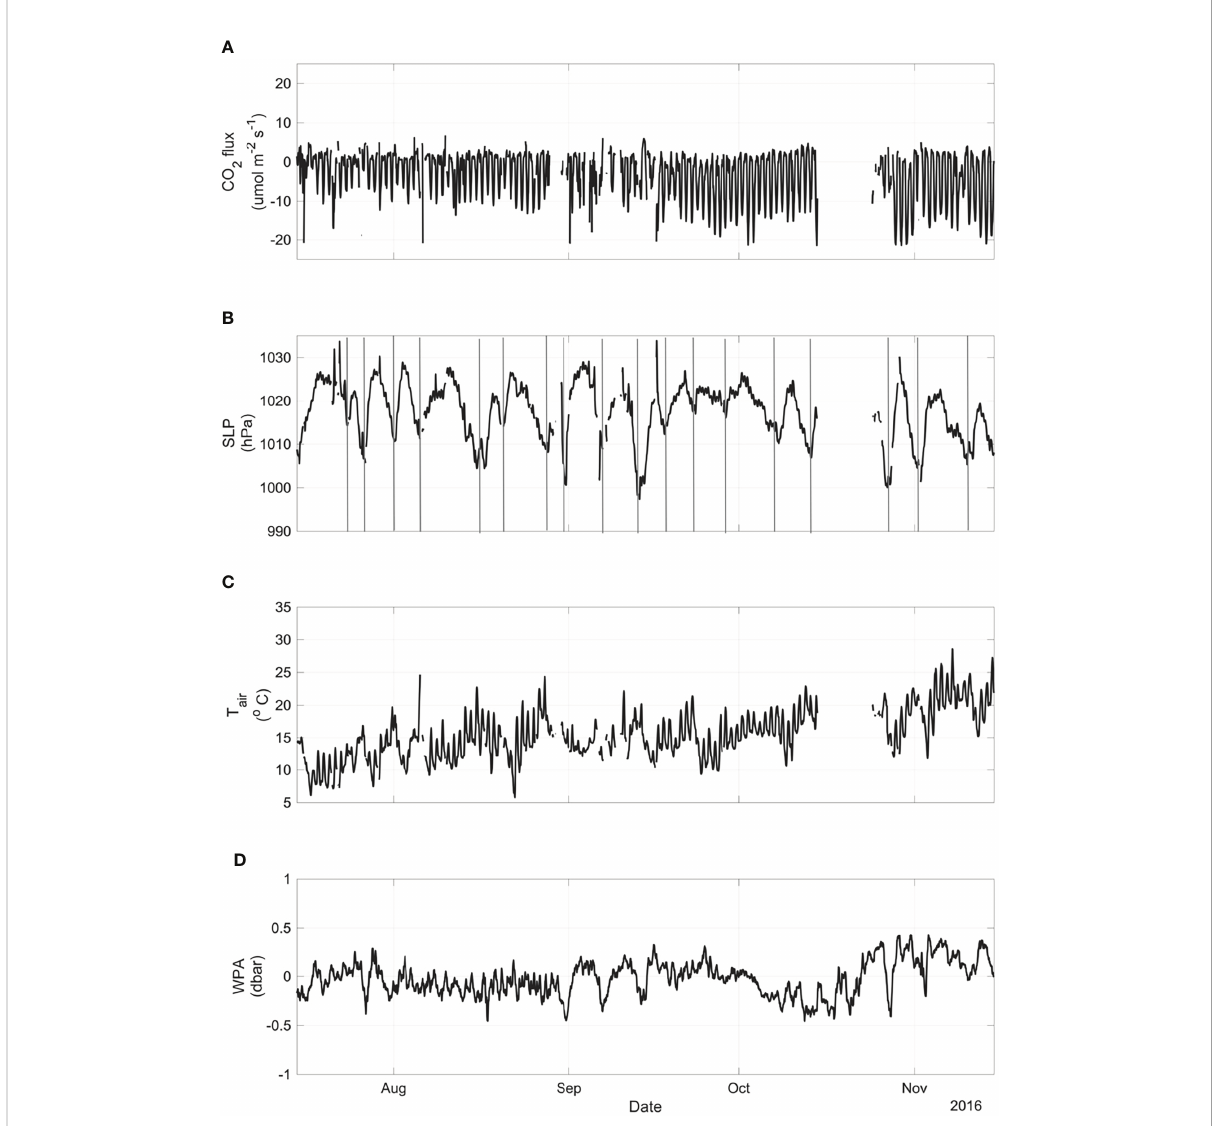
FIGURE 2 Time series of (A) CO 2 fl uxes at the salt marsh-atmosphere interface; (B) sea level pressure (SLP); (C) air temperature (T air ); (D) water pressure anomaly (WPA) for the period spanning from July up to November 2016. The vertical gray lines in (A) indicate the pressure troughs associated with the passage of atmospheric cold fronts in the study